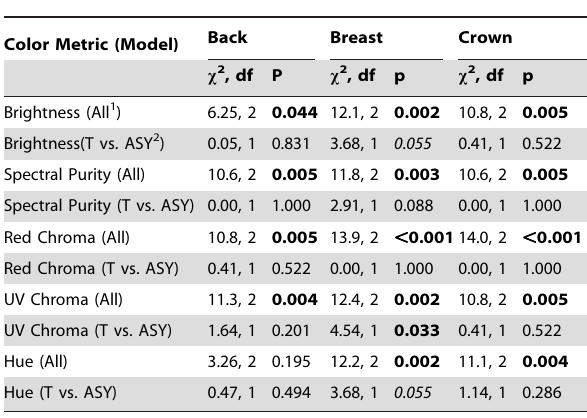
Table 2. Summary of statistical differences in feather color at implant removal between treatment types (T, control) and unmanipulated (ASY) males in all measured color metrics and for three representative plumage patches (red, carotenoid- pigmented back feathers and black melanin-pigmented breast and crown